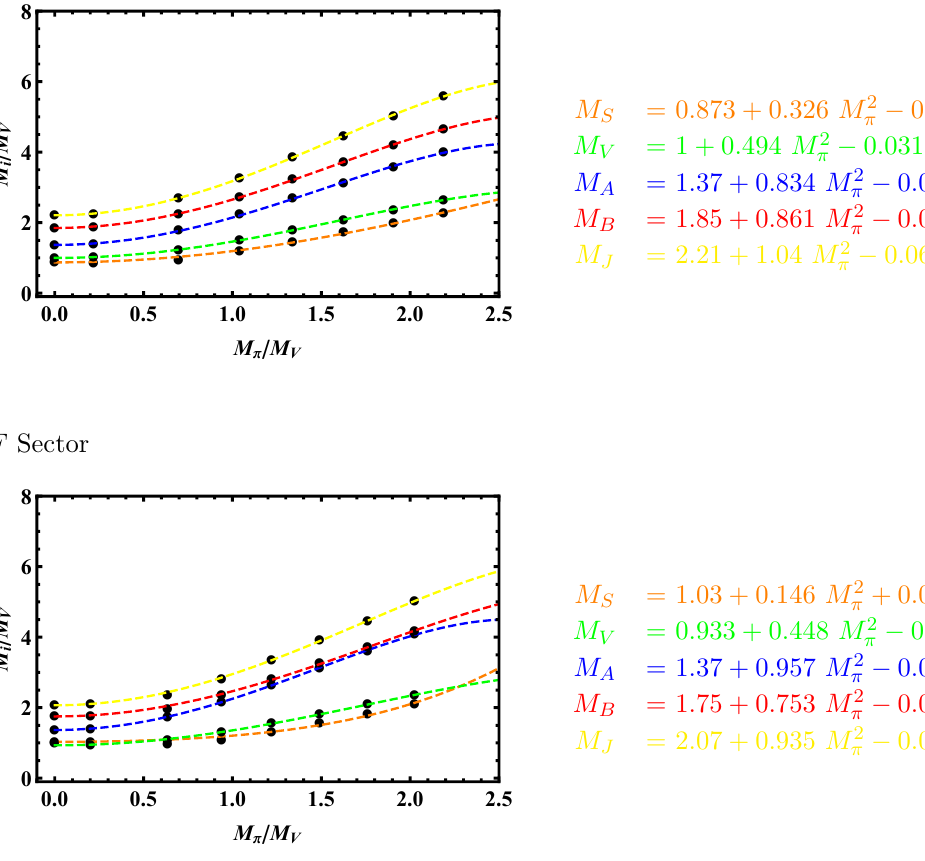
Figure 16. SU(4) 2 F, 2 ¯ F, 4 A 2 — The growth of the A 2 and F sectors spectra as we increase the quark mass in the UV. The masses are rescaled with respect to the vector meson mass in the A 2 representation at m q | UV = 0 in accord with the presentation in table 5. Here M π is the pNGB mass in units of the vector meson mass at m q | UV = 0